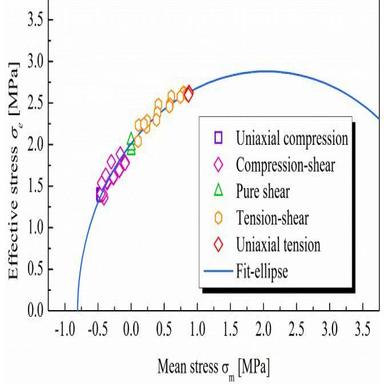
The initial yield surface of PMI foam material (density: 0.075 g/cm3 ). The open scatters denote the experimental data of Mises and mean stresses and each open scatter corresponds to one test. The solid blue curve is the fitting yield surface of PMI foam material based on these experimental data (For interpretation of the references to color in this figure legend, the reader is referred to the web version of this article.).